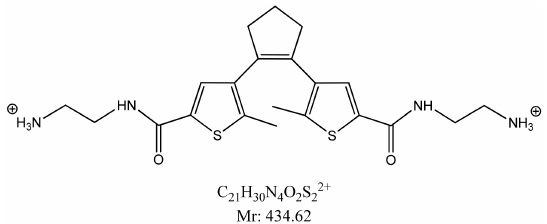
Figure 16. 2,2 (cid:48) -((4,4 (cid:48) -(cyclopent-1-ene-1,2-diyl)bis(5-methylthiophene-2,2 (cid:48) -carbonyl))bis(azanediyl)) diethanaminium (DAE-NH 2